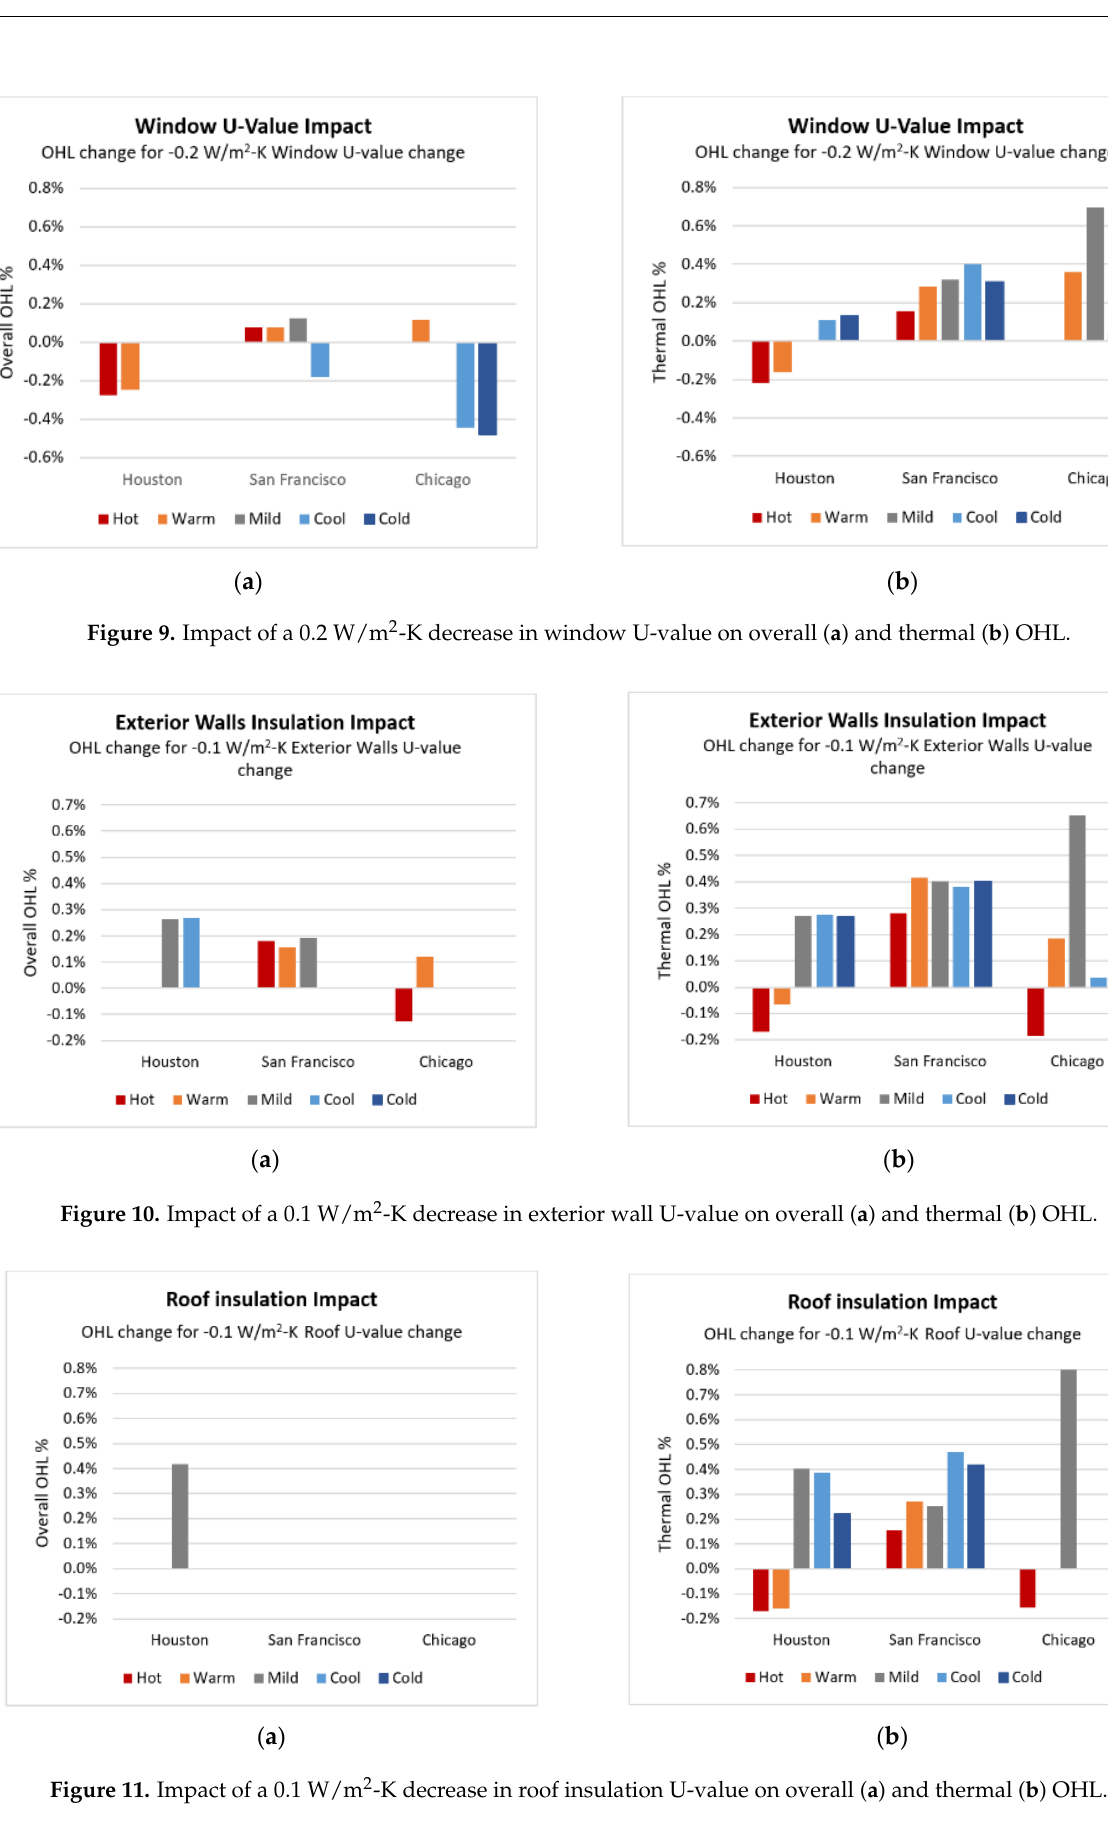
Figure 11. Impact of a 0.1 W/m 2 -K decrease in roof insulation U-value on overall ( a ) and thermal ( b )